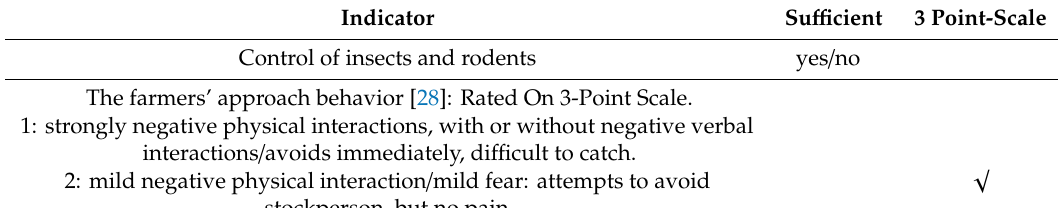
Table A2. Management-based measures identified by the authors. Indicator